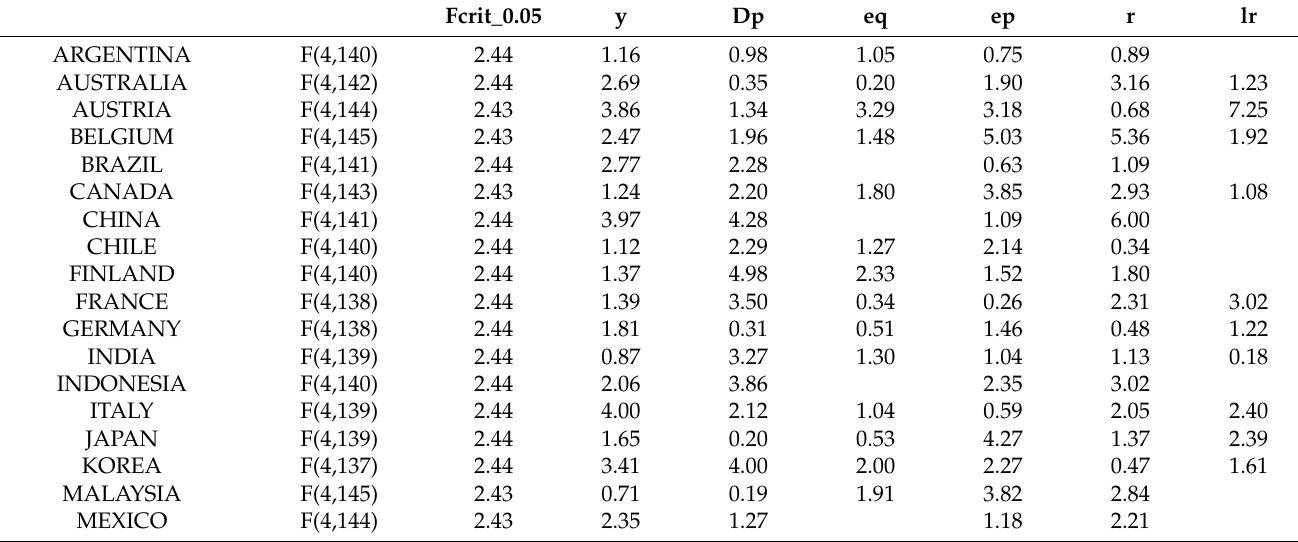
Table A3. F-Statistics for the Serial Correlation Test of the VECMX*